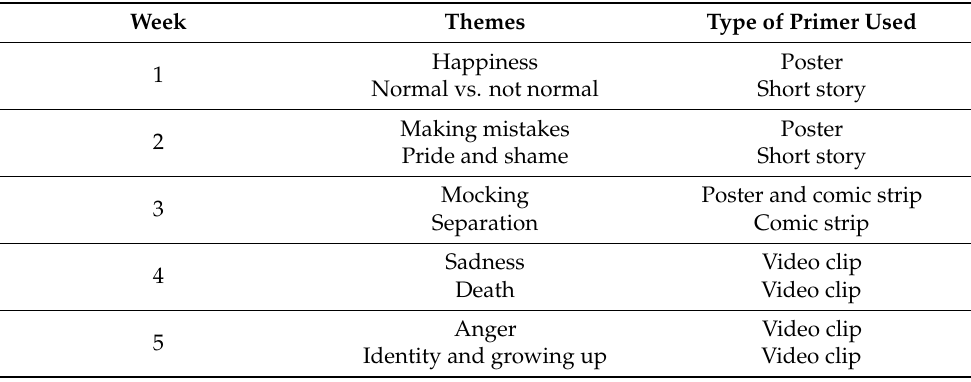
Table 1. Philosophy for children